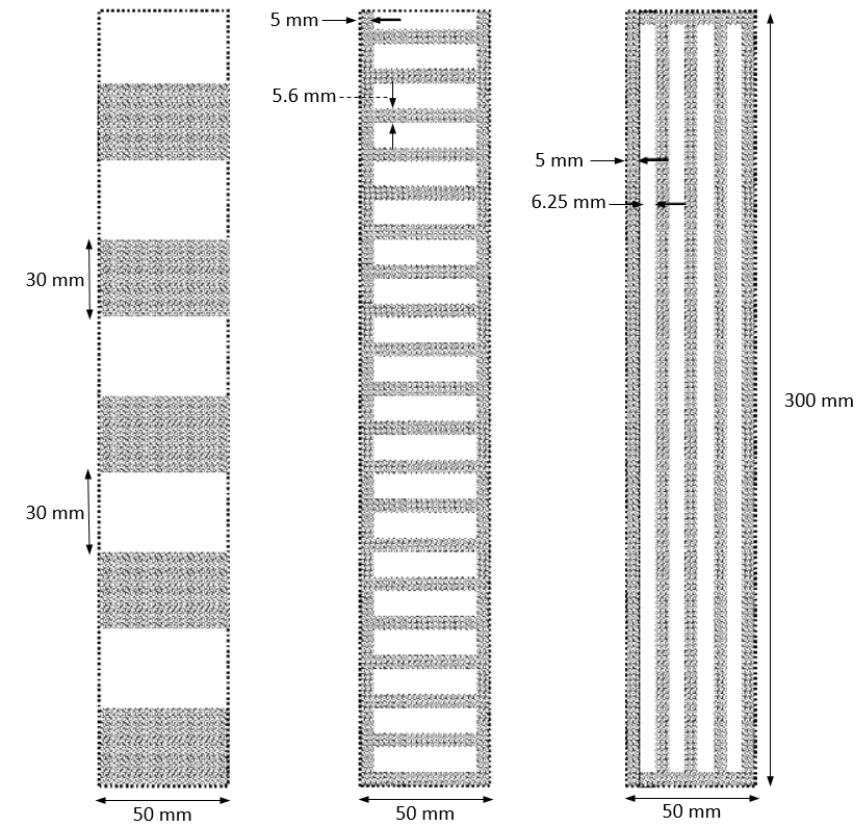
Figure 4. Dimension of the patterned models of porous media.